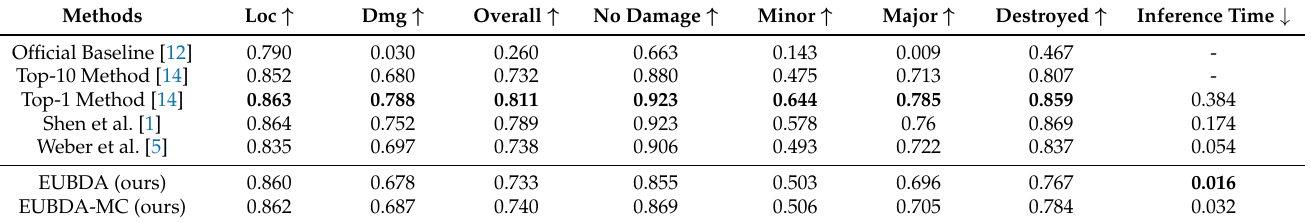
Table 6. The comparison with recent advanced framework in building damage assessment. The best overall F1 score is achieved by top method in Xview Challenge [14] while the proposed method (EUBDA) achieves the best inference